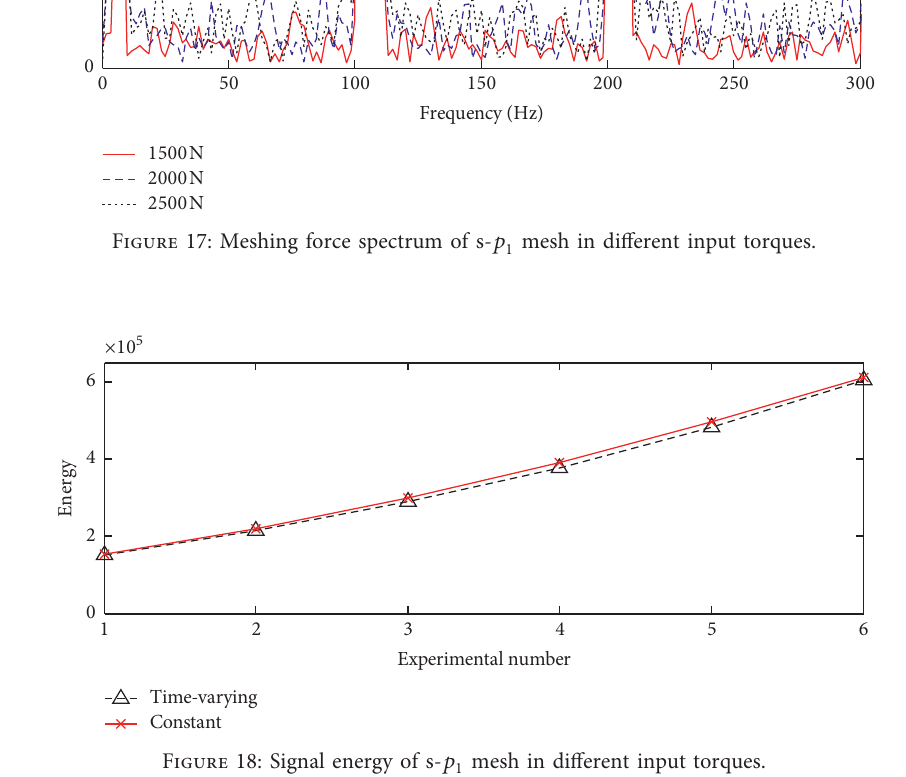
mesh in different input torques. 1